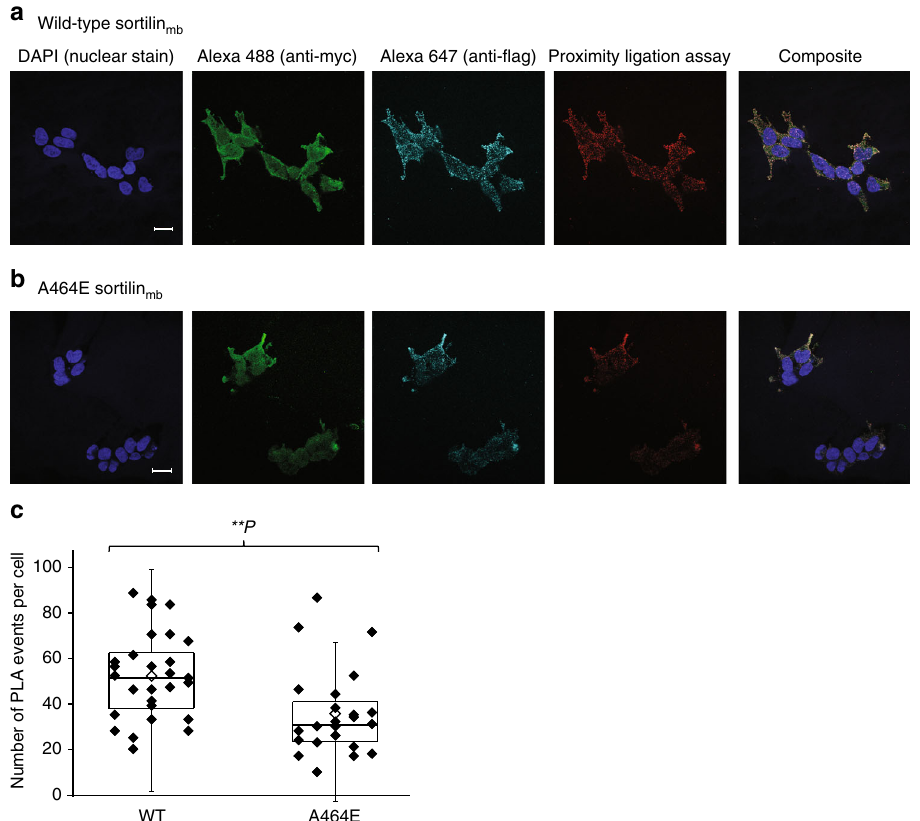
Fig. 7 Sortilin dimerizes on the cell surface. a Analysis of the interaction of wt sortilin mb-myc with sortilin mb- fl ag by Duolink PLA in adherent HEK cells that co- express wt sortilin mb-myc and sortilin mb- fl ag . Flag-tagged proteins were detected with mouse anti- fl ag antibodies (in cyan) and myc-tagged proteins with rabbit anti-myc antibodies (in green). Protein interactions were detected with Duolink PLA labeled in red. Each red spot is regarded as a single interaction. Images were collected by confocal microscopy. Scalebars, 20 μ m. b Similar to A but now with sortilin A464E. c Distribution of the number of PLA events per cell ( N > 22) expressing wt or mutant A464E sortilin mb-myc and sortilin mb- fl ag . The upper and lower quartiles of each sample are represented by the upper and lower sides of the boxes; the medians are represented by the black horizontal lines, and the means by hollow diamonds. The range of the whiskers indicate the statistical outliers with a coef fi cient 1.5. Mann – Whitney test was used, ∗∗ p <